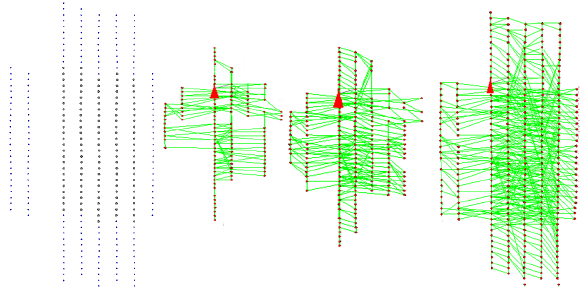
Figure 2: Left: Blue dots represent oblique projection centers (PP), grey dots represent oblique and nadir PP; right: three stages of image block concatenation.